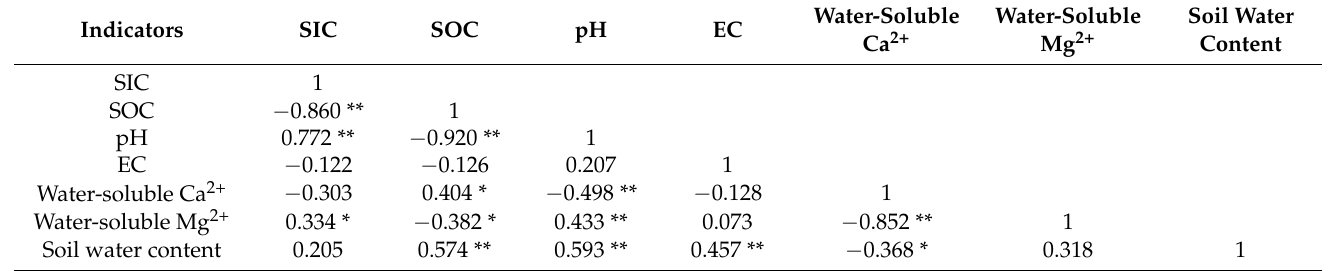
Table 2. Correlation analysis between soil inorganic carbon content and physiochemical properties ( n = 36).